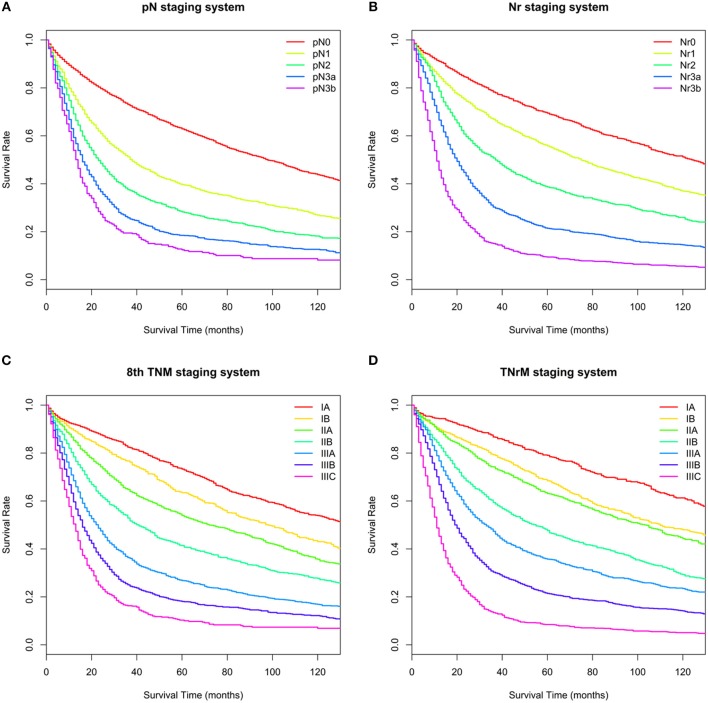
Overall survival (OS) for the validation set based on different staging systems. (A) pN staging system. Five-year OS for the pN categories (pN0–3b) was 62.9, 40.0, 28.3, 18.5, and 12.5%, respectively. (B) Nr staging system. Five-year OS for the Nr categories (Nr0–3b) was 69.4, 55.8, 38.7, 21.4, and 9.4 %, respectively. (C) 8th TNM staging system. Five-year OS for the 8th TNM stages (IA–IIIC) was 73.3, 63.5, 53.9, 41.4, 26.8, 18.1, and 10.3%, respectively. (D) TNrM staging system. Five-year OS for the TNrM stages (IA–IIIC) was 79.0, 68.5, 63.1, 47.7, 35.8, 21.4, and 8.5, respectively.